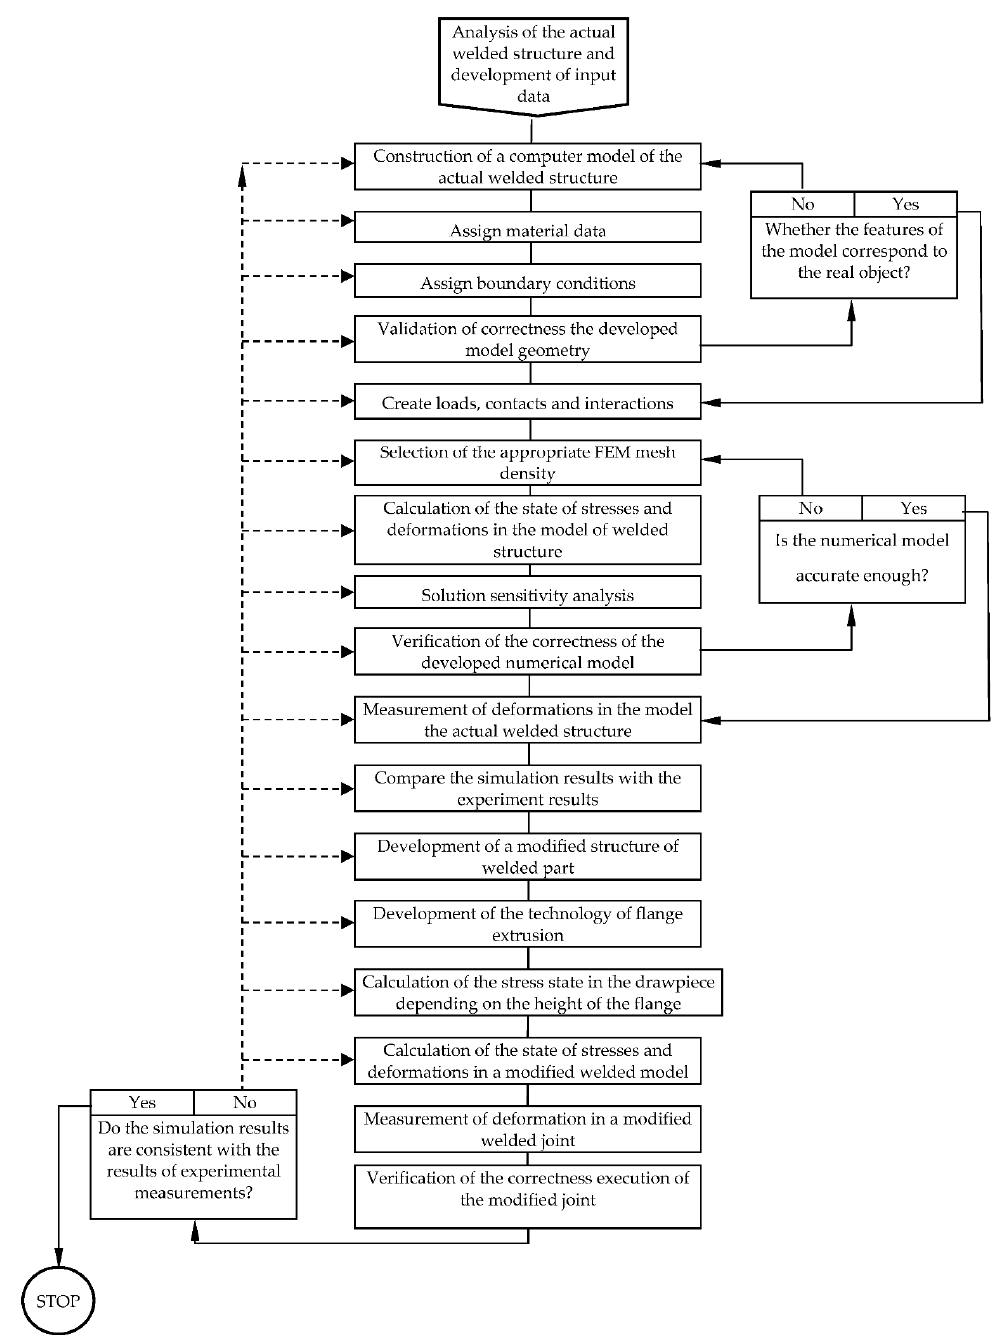
Figure 2. Flow chart of finite element analysis of coupled thermal and mechanical effects during welding of thin-walled structures.